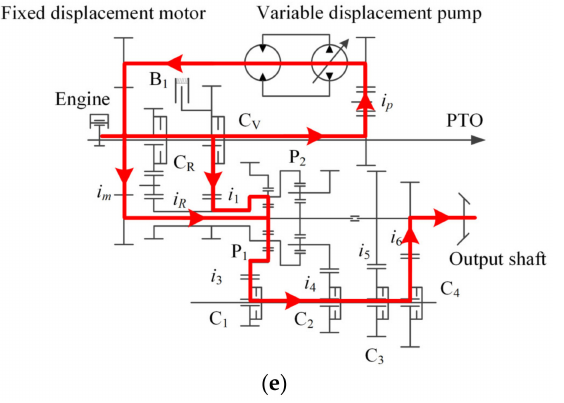
Figure 2. The schematic diagram of power flow in different stages. ( a ) H 0 section; ( b ) HM 1 section; ( c ) HM 2 section; ( d ) HM 3 section; and ( e ) HM 4 section.